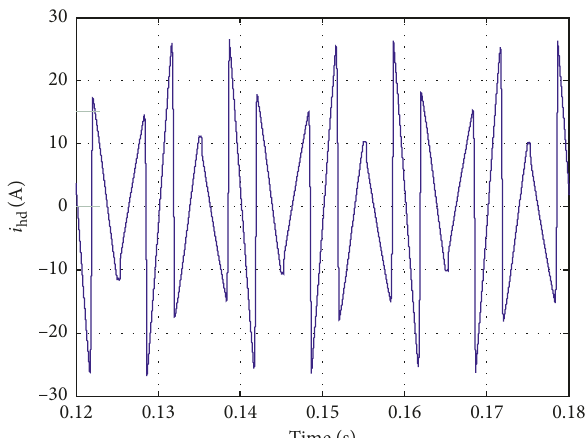
Figure 11: Waveform of harmonic currents.